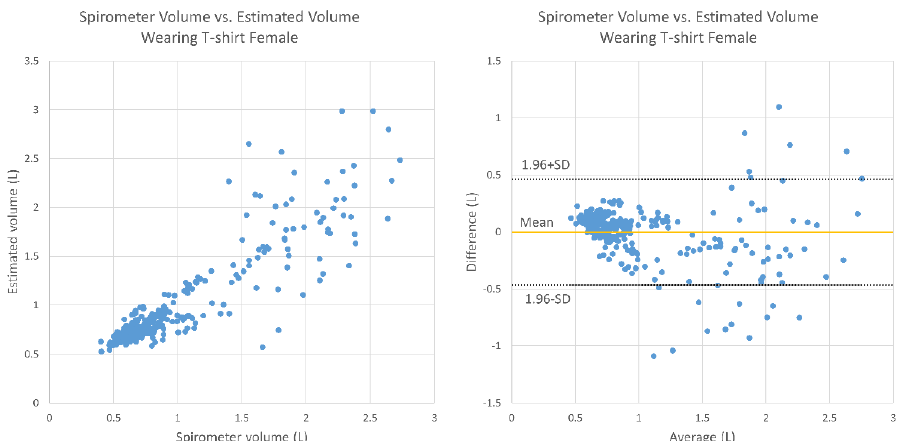
Figure 10. Bland–Altman plot for TV obtained using the spirometer and the estimated TV under T-shirt-wearing conditions (female subjects).